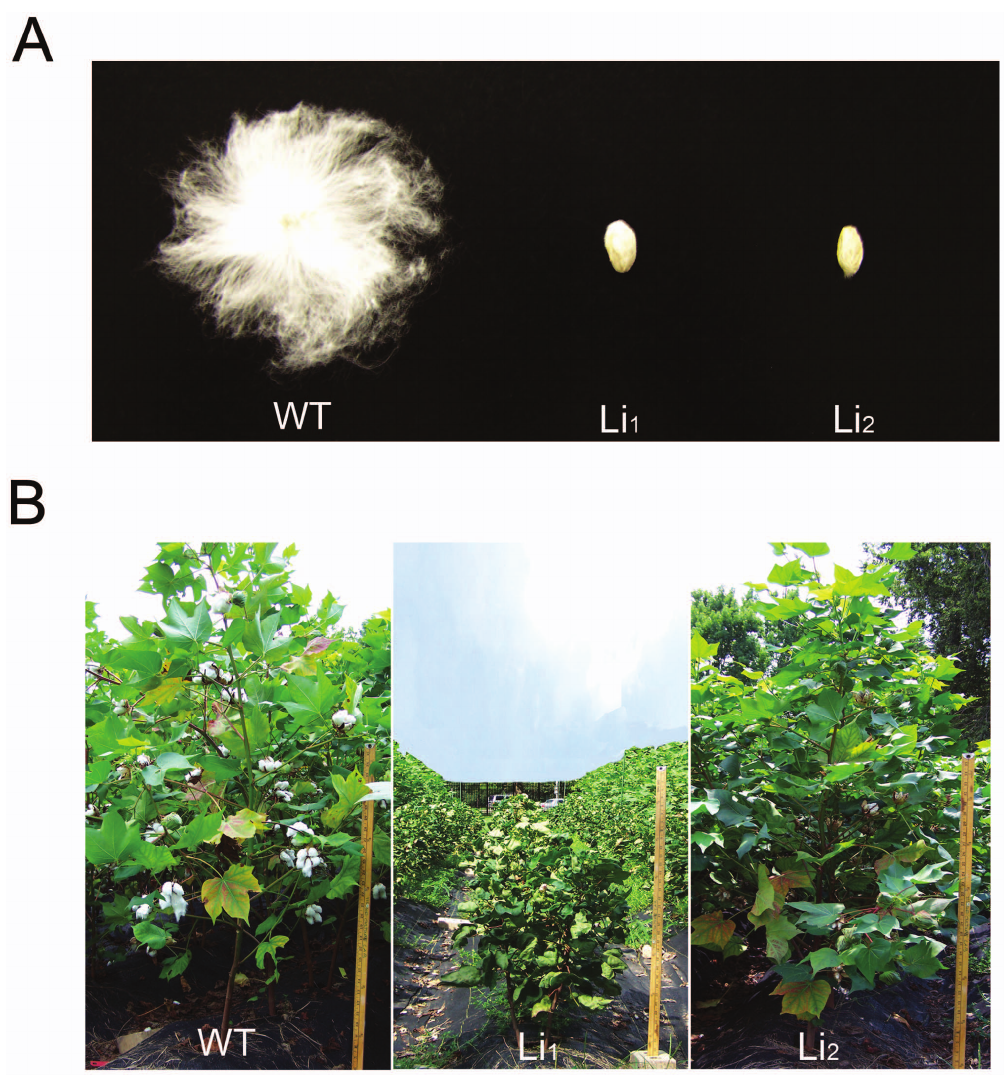
Figure 1. Cotton seed fibers (A) and plants (B) of wildtype DP5690 (WT), Li 1 mutant and Li 2 mutant. Plants were grown in the USDA-ARS Southern Regional Research Center field in New Orleans, LA.